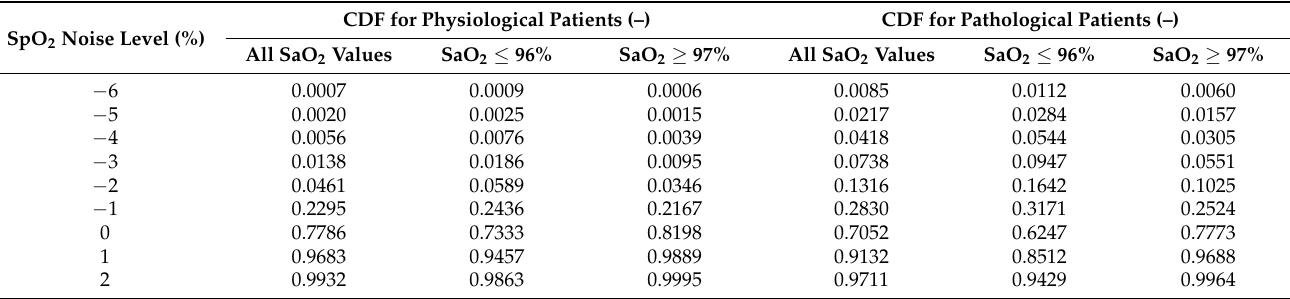
Table A1. Cumulative distribution function of the SpO 2 measurement